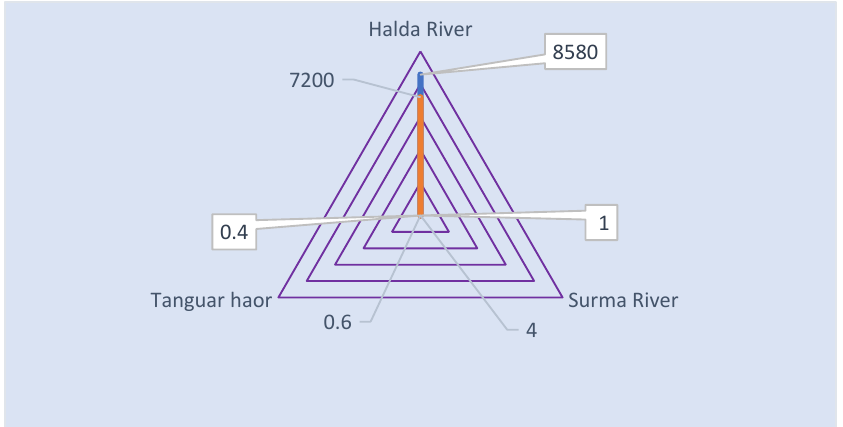
Figure 6. The radar graph showed the amount of spawn collected from the study area.